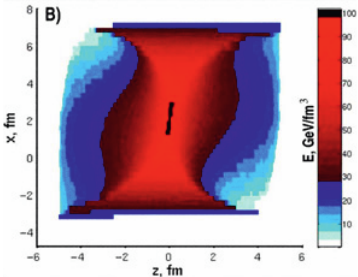
Figure 1. The initial state energy density distribution shown in the Reaction Plane, in the [ x , z ], plane. This initial state is constructed based on a Glauber model, via fire-streaks, which extend longitudinally. This extension is slowed down by the attractive, chromo-electric, coherent Yang-Mils fields. The resulting string-rope tension is smaller when we have less color charges at the end of the streaks, and this results in a longer streaks and smaller energy density at the top (projectile) and bottom (target) sides. The central streaks that stopped stronger, start a 1D Riemann scaling expansion. This initial state conserves energy, momentum, angular momentum, and shows initial vorticity and longitudinal shear. From ref. [4,